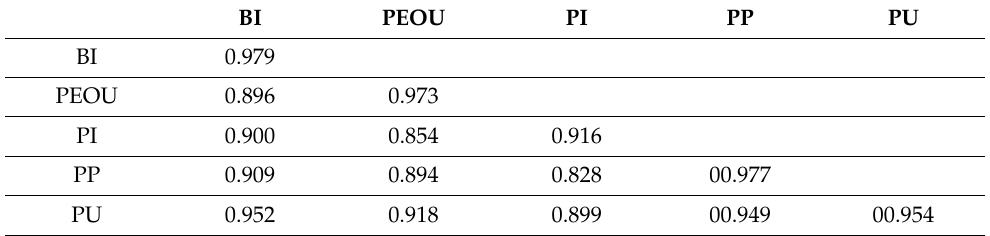
Table 5. Measurement model’s discriminant validity (Fornell Larcker